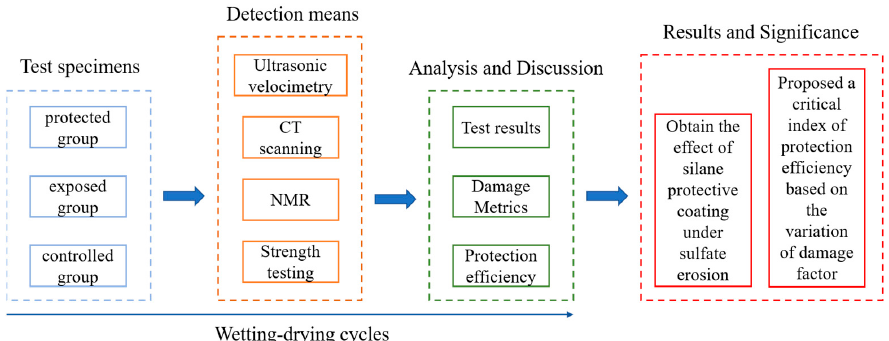
Figure 3. The overall structure of the paper.